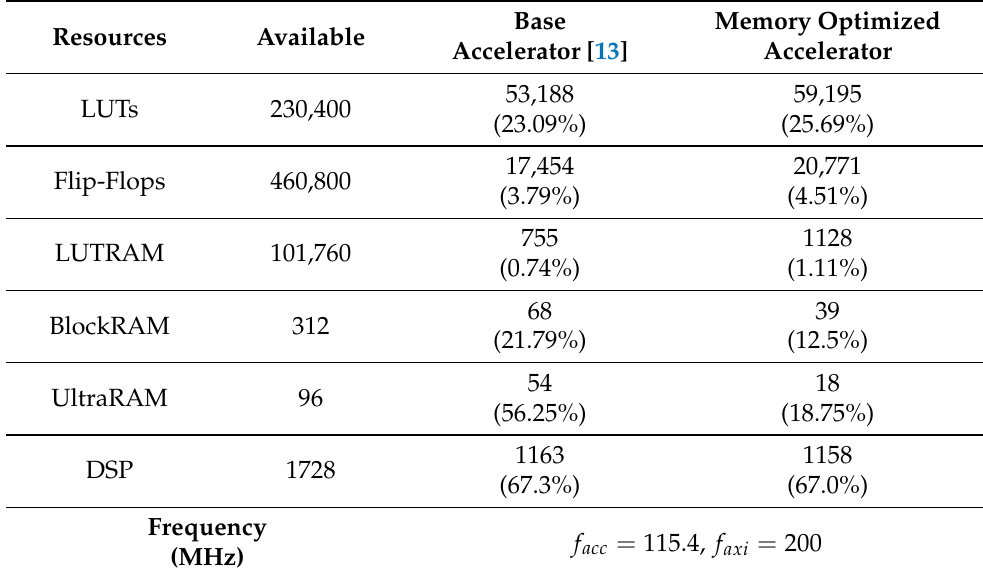
Table 2. Zynq Ultrascale+ XCZU7EV implementation